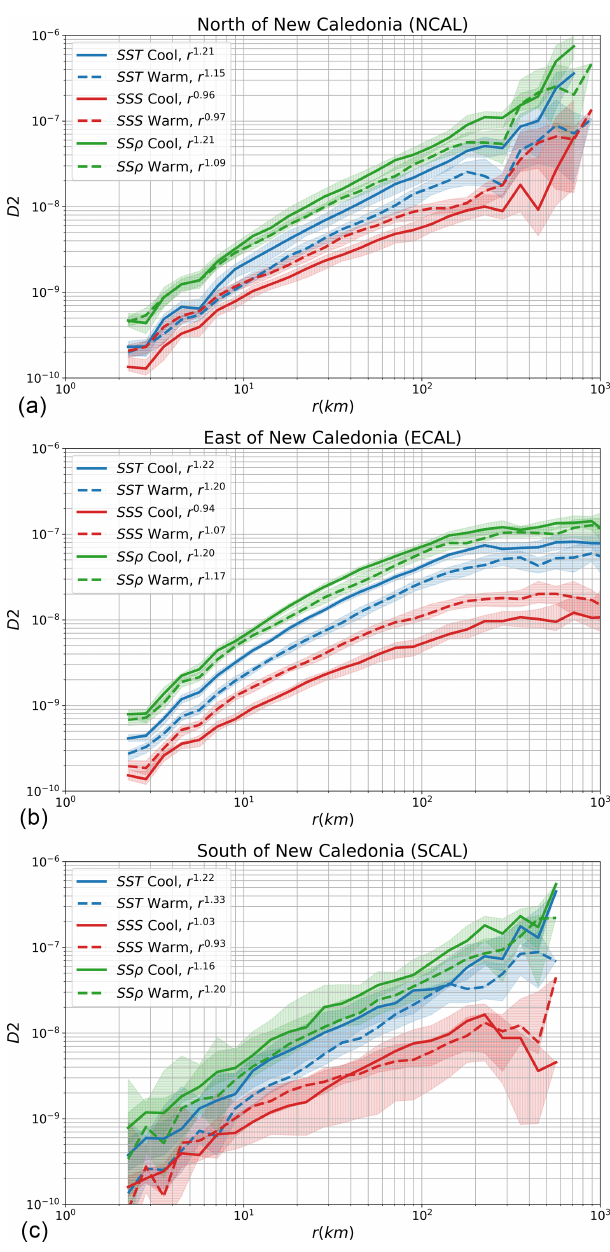
Figure 7. Second-order structure functions computed for sea sur- face salinity (SSS, red curves), sea surface temperature (SST, blue curves), sea surface density (SS ρ , green curves) in three regions surroundings New Caledonia: NCAL (a) , ECAL (b) and SCAL (c) . Seasonality is shown between cool (June to November, solid curves) and warm (December to May, dashed curves) seasons. Values of the structure function slopes, estimated between 3 and 100km, are given in the caption. Colour shading corresponds to confidence in- tervals at 5% and 95%, estimated from a bootstrap